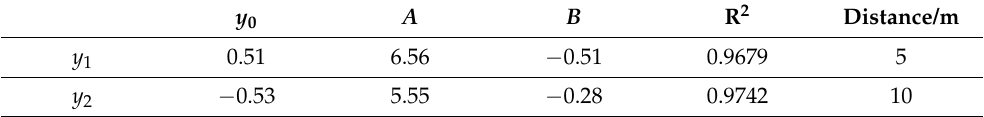
Table 6. The fitting parameters of CO 2 concentration during medium-pressure